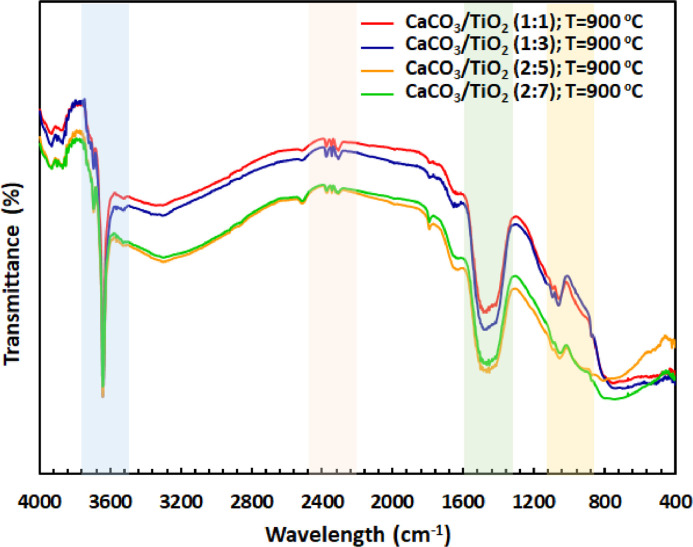
FTIR spectra of CaTiO3 prepared with different CaCO3/TiO2 molar ratio.